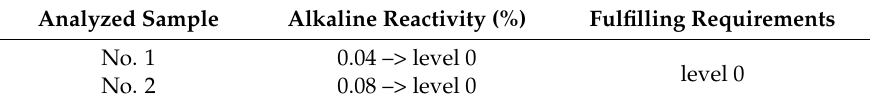
Table 5. Results of the alkaline reactivity of vitrified